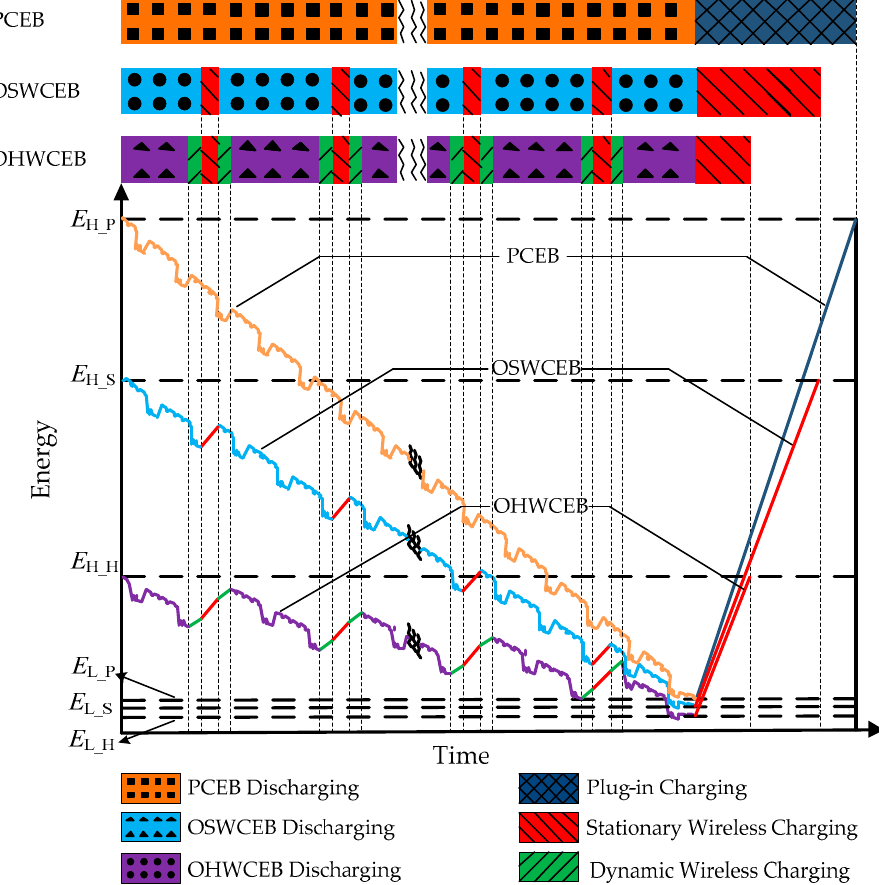
Figure 5. Battery energy variations of plug-in charged electric bus (PCEB), opportunistic stationary